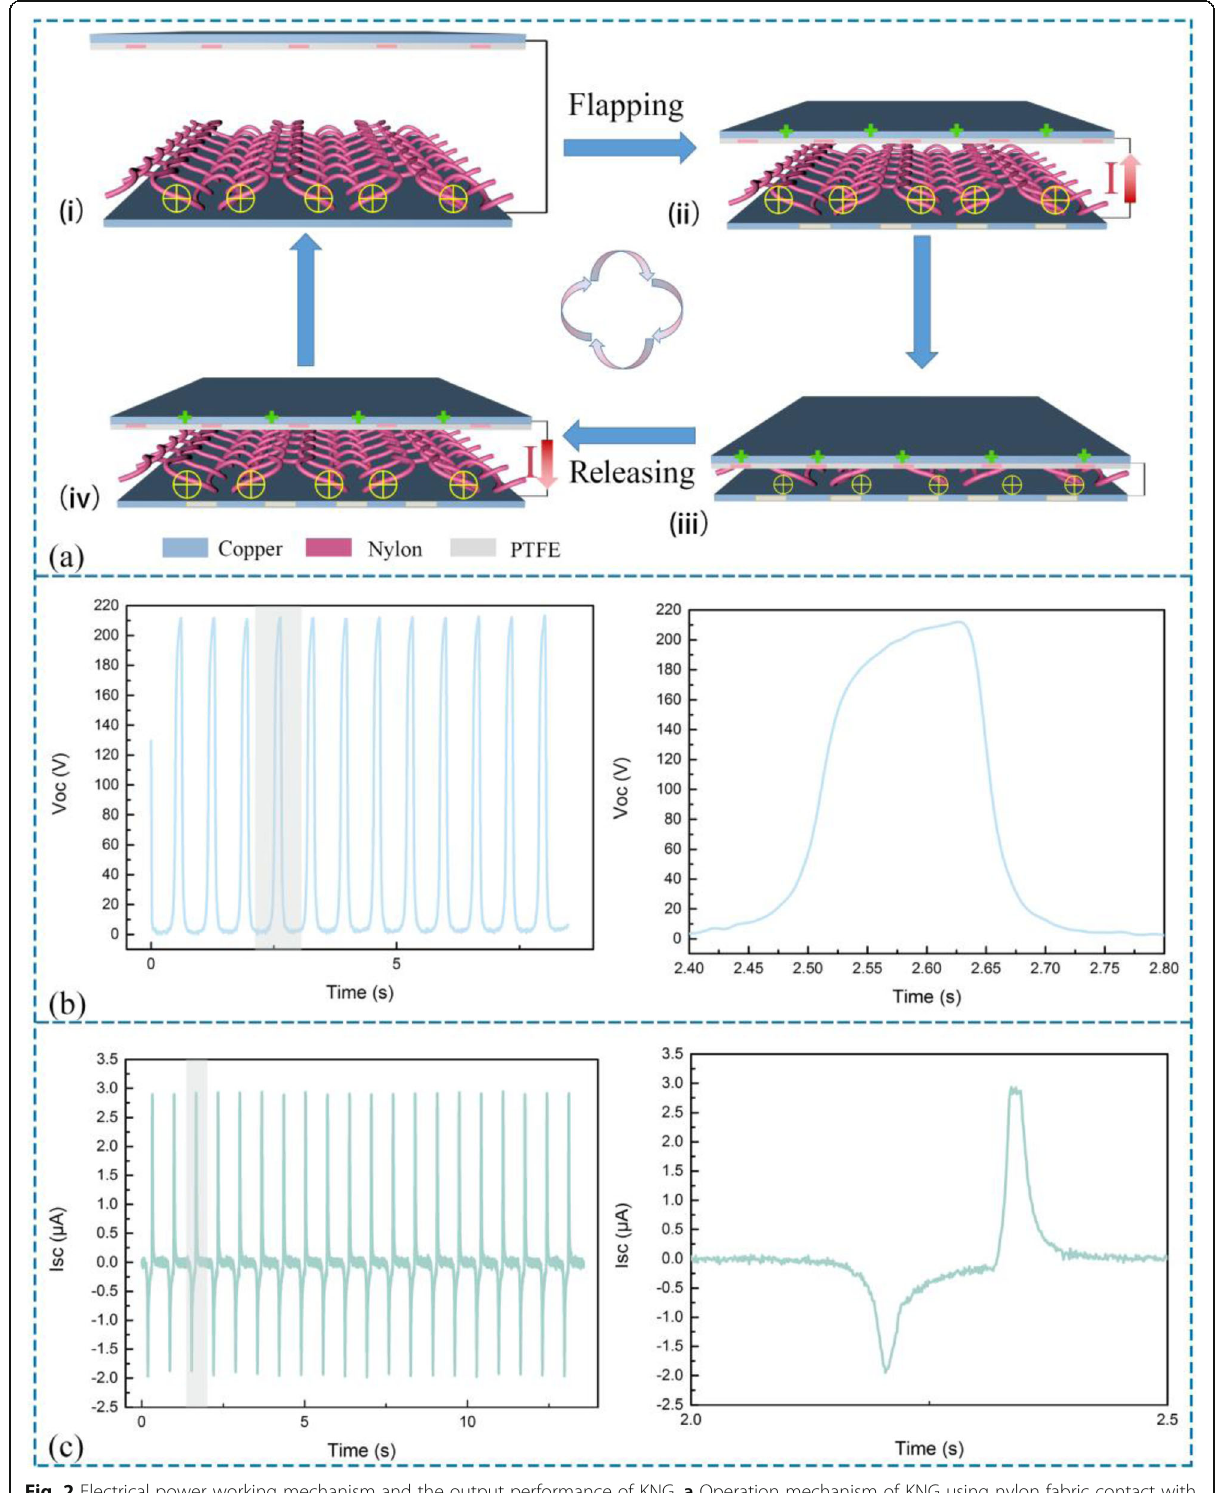
Fig. 2 Electrical power working mechanism and the output performance of KNG. a Operation mechanism of KNG using nylon fabric contact with PTFE member. b Voc of KNG and enlarged image for one cycle. c Isc of KNG and enlarged image of one